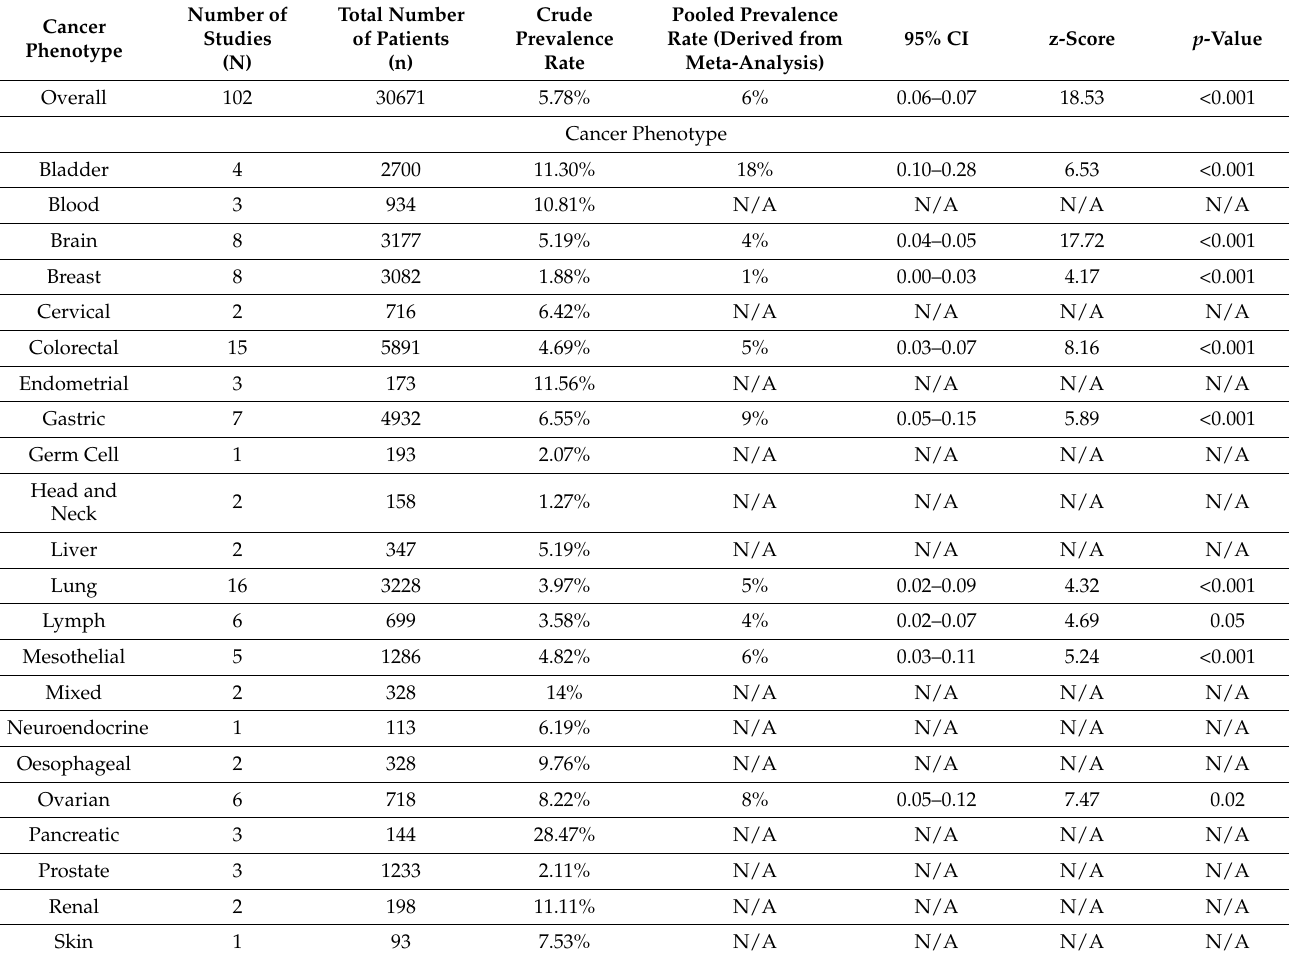
Table 4. Pooled and crude prevalence of venous thromboembolism across various cancer